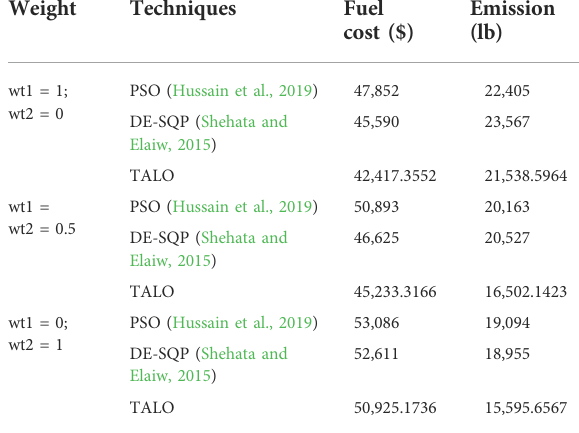
FIGURE 3 Graphical representation vs optimisation techniques.